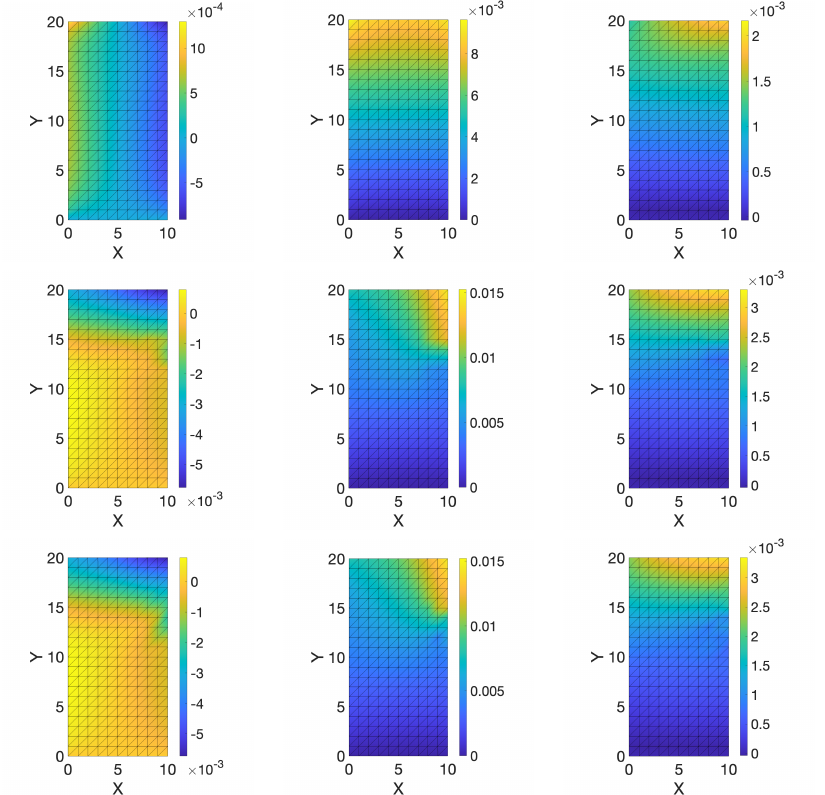
Figure 4. Top view of x ( left ), y ( center ) and z ( right ) components of the displacement field associated with the nominal solution ( top ); reference solution that takes into account the real damaged region ( middle ) and corrected model solution ( bottom